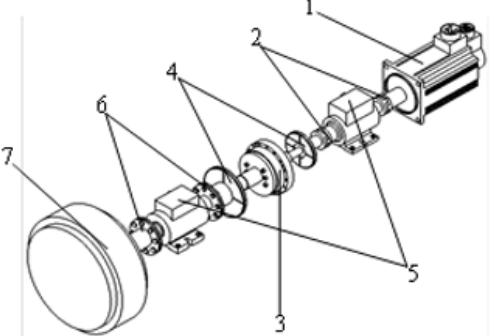
Figure 1. RV reducer performance parameter test device.